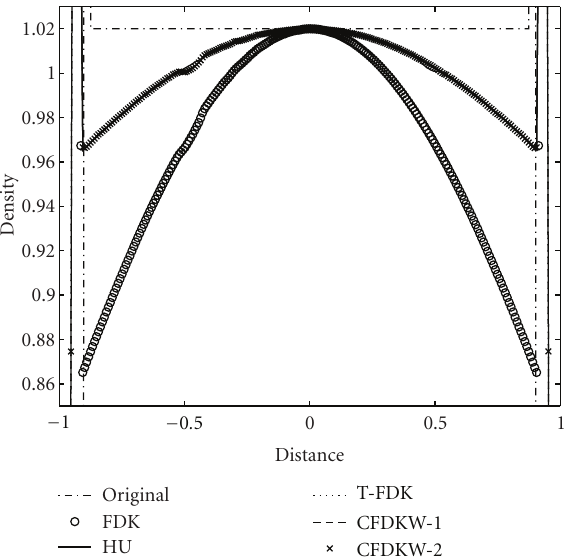
Figure 8: Illustration of axial intensity drop in full-scan recon- structions of Shepp-Logan low-contrast phantom, vertical intensity profile of the Shepp-Logan low-contrast phantom at z = 0 in Figure 7.